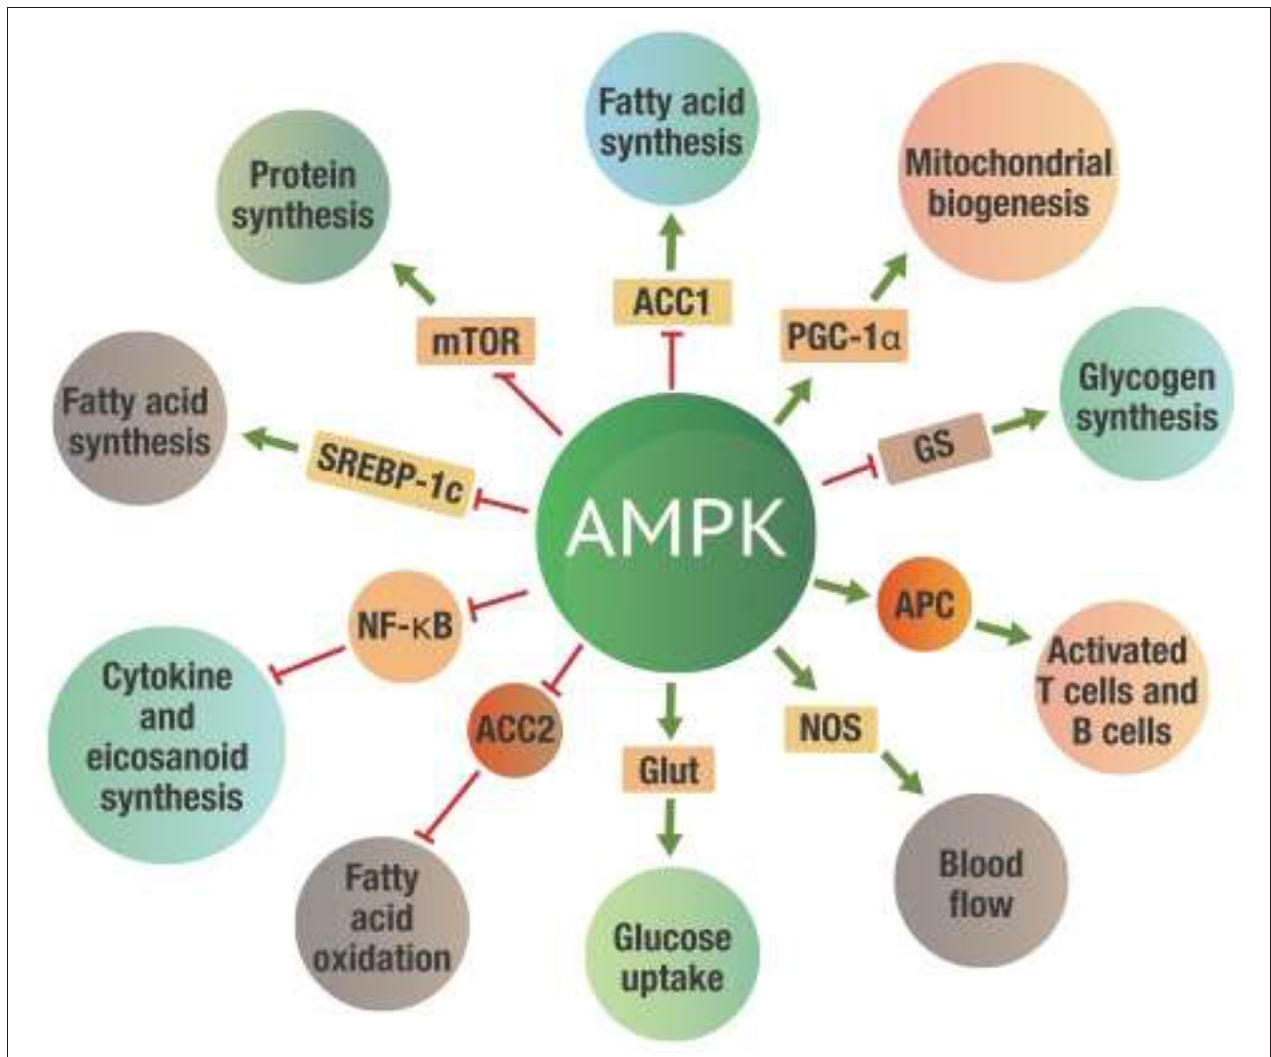
FIGURE 4 | Metabolic effects of AMPK activation. Green arrows on the “spokes” indicate activation, red lines with a bar at the end indicate inhibition. ACC 1 and ACC2, -Acetyl-CoA carboxylase 1 and 2; AMPK, 5’ adenosine monophosphate-activated protein kinase; Glut, Glucose transporter protein; GS, Glycogen synthetase; mTOR, mammalian target of rapamycin; NF- κ B, Nuclear factor kappa-B; NOS, Nitrogen oxide synthetase; PGC-1 α , Peroxisome proliferator-activated receptor gamma coactivator 1-alpha; SREBP-1c, Sterol regulatory element-binding protein